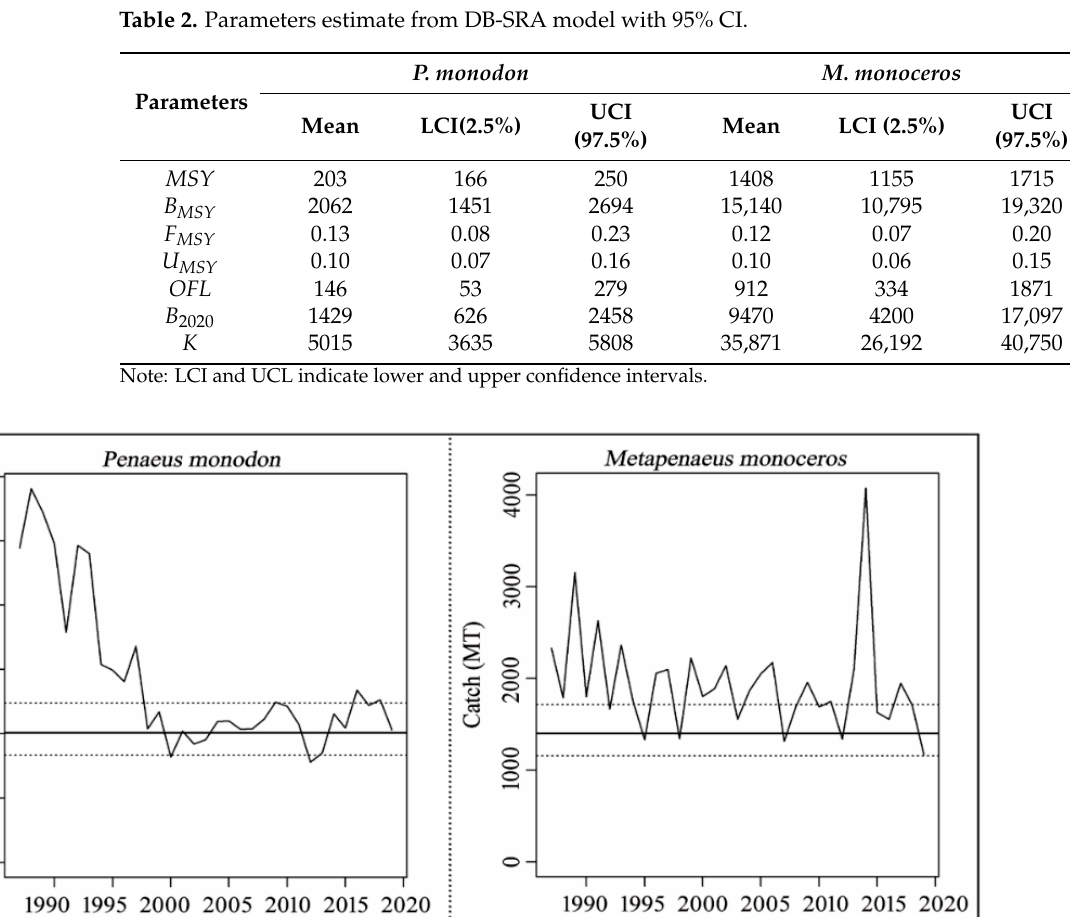
Table 2. Parameters estimate from DB-SRA model with 95% CI.